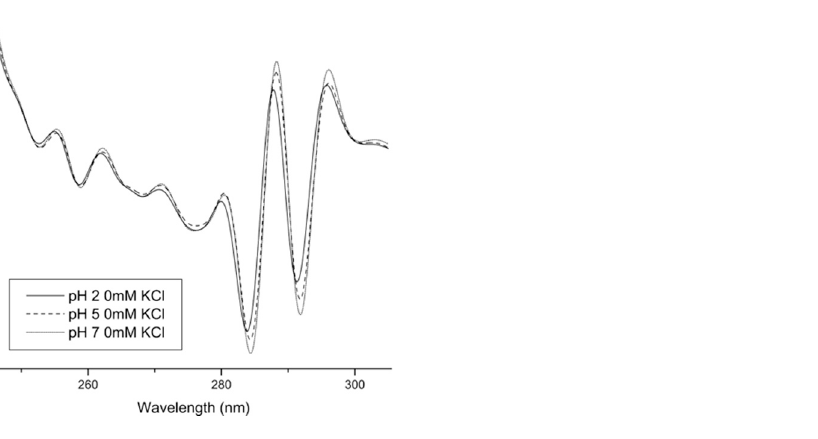
Figure 7. Second derivative absorbance spectra for UV–Vis analysis of IgG at three different pH values without KCl. The largest shifts were observed for the two peaks at approximately 284 and 292 nm. Reproduced with permission from [76], Elsevier, 2008.